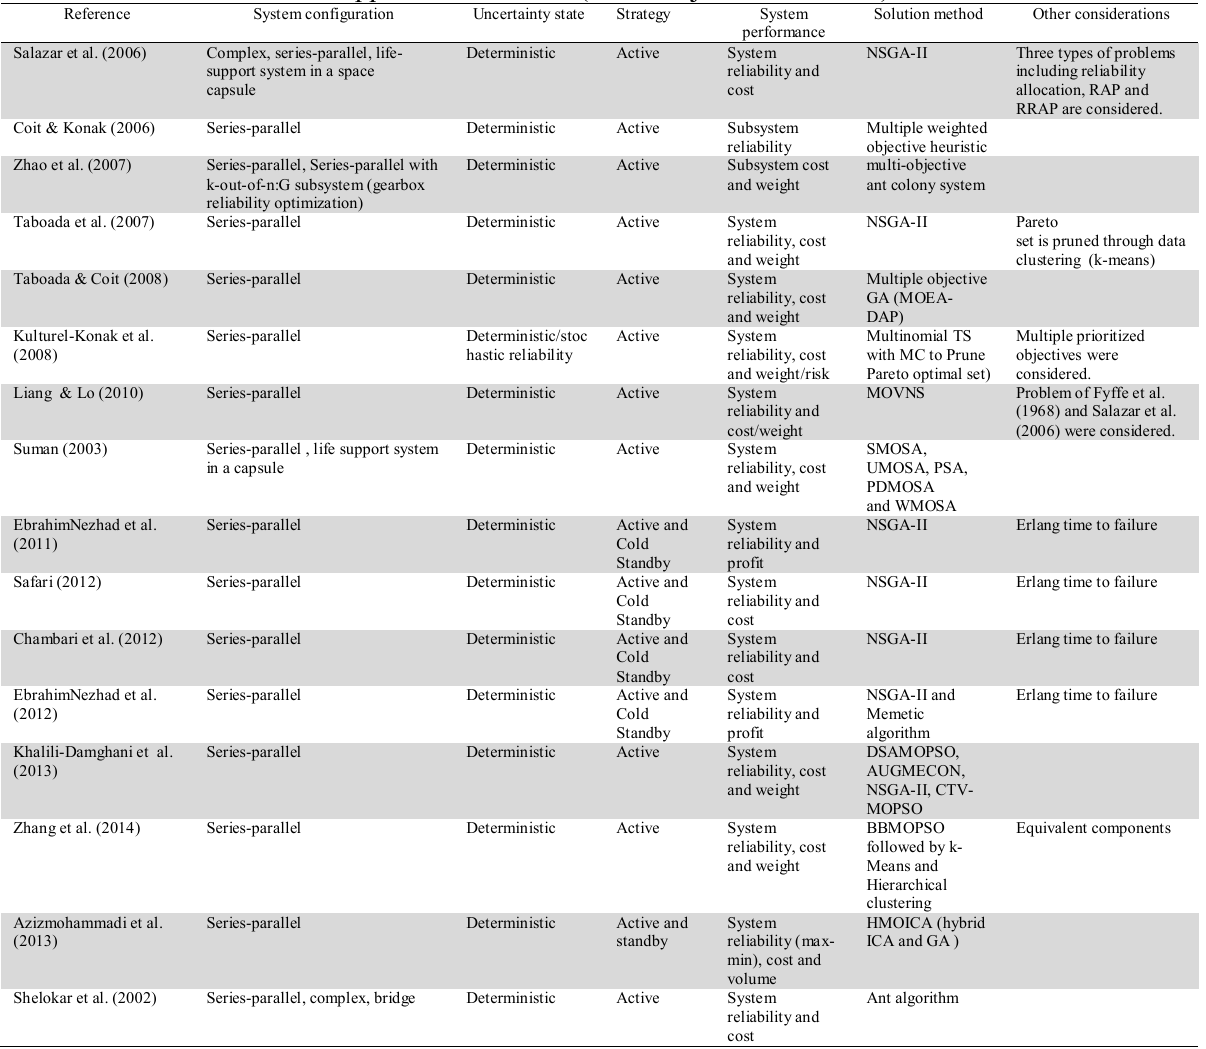
Heuristic and Meta-heuristic approaches for RAP (Multi Objective